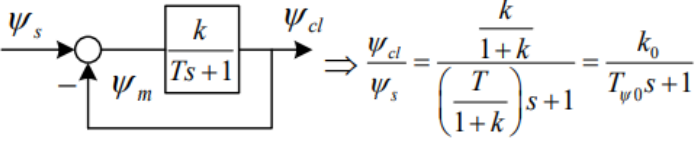
Figure 26. Inertia tracking strategy of the measurement axis.